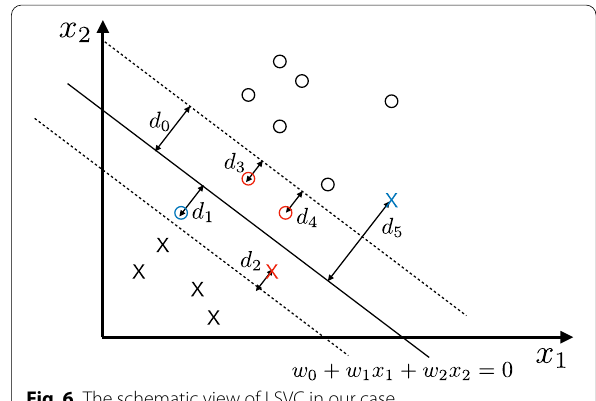
Fig. 6 The schematic view of LSVC in our